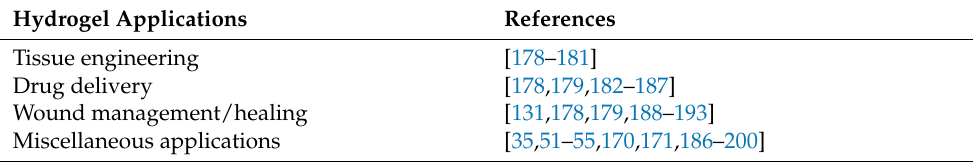
Figure 6. Demonstration of the healing process in a hydrogel [35]. Self-healing hydrogels have a variety of potential applications, as shown in Table 5. Table 5. Self-healing hydrogels potential applications. Hydrogel